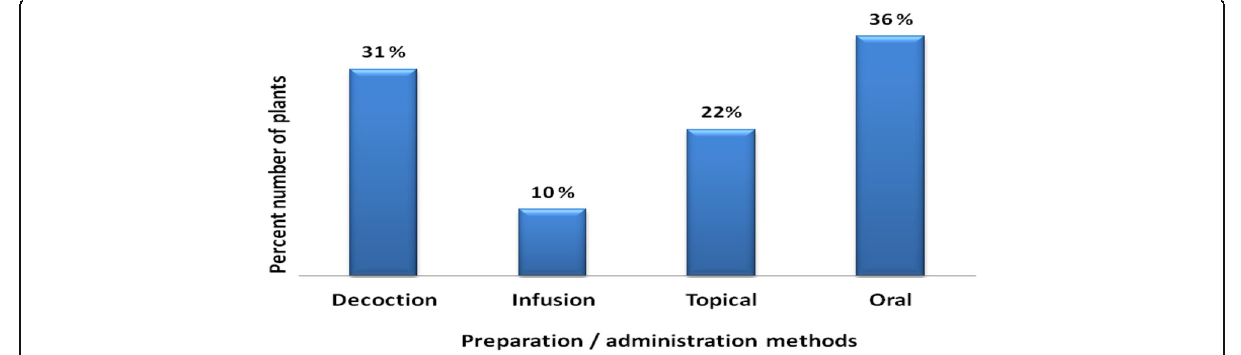
Fig. 5 Percentage of species prepared using different methods